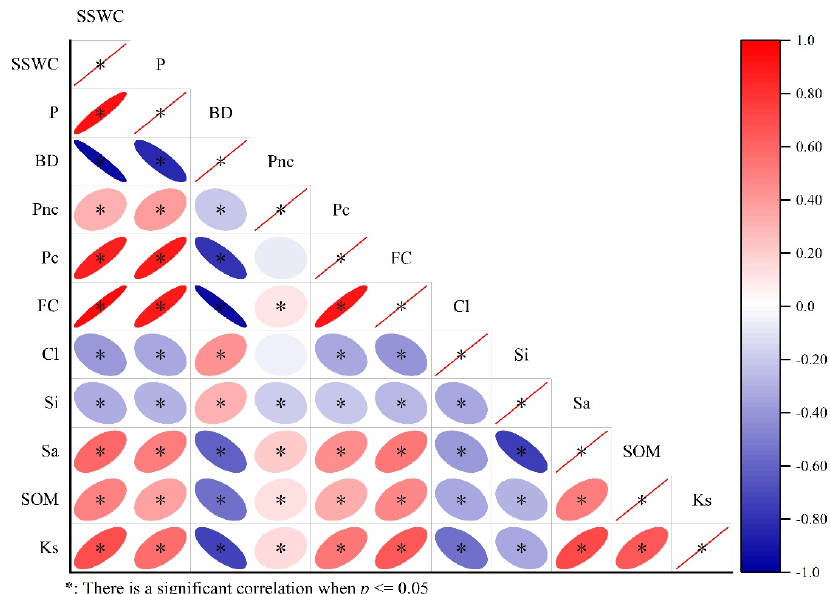
Figure 2. Pearson correlation analysis between K S and soil properties. Exploratory factor analysis was carried out for 10 basic physical and chemical prop- erties of soil by principal component analysis, as shown in Table 2. There are generally two selection criteria for principal component factors: (1) select principal component fac- tors with characteristic roots greater than 1.00; (2) select principal component factors with a cumulative contribution rate greater than 85%. The maximum variance method was used to carry out the orthogonal rotation and shows the factor load matrix after rotation. The eigenvalues of the first five principal component factors were greater than 1 and ex- plained 94.402% of the variation of soil properties. The PC1 could explain 45.358% of the variation, and it had high positive loadings from SSWC (0.922), P (0.916), P C (0.941), and FC (0.948), while having a high negative loading from BD ( − 0.865). PC1 was named the “pore of soil” component, because it chiefly explained the variations of soil bulk density and pore characteristics. The PC2 explained 17.516% of variation with high negative load- ing from Si ( − 0.914) and positive loading from Sa (0.843); hence, PC2 was defined as the “silt and sand” component. The PC3 had a high loading from Cl ( − 0.95) that explained 12.517% of variation, and it was named the “Clay” component. The PC4 explained 11.508% of variation and had a high loading from P NC (0.984). PC4 was named the “non- water retention” component because these non-capillary porosity samples have no capil- lary function and are filled with air. The last PC also had one high loading from SOM (0.917), and it explained 7.503% of variation; PC5 was named the “organic matter” com- ponent.